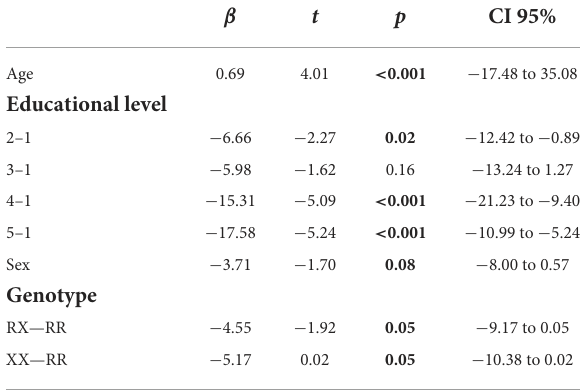
TABLE 2 Effect of genotype on functional fitness classification.